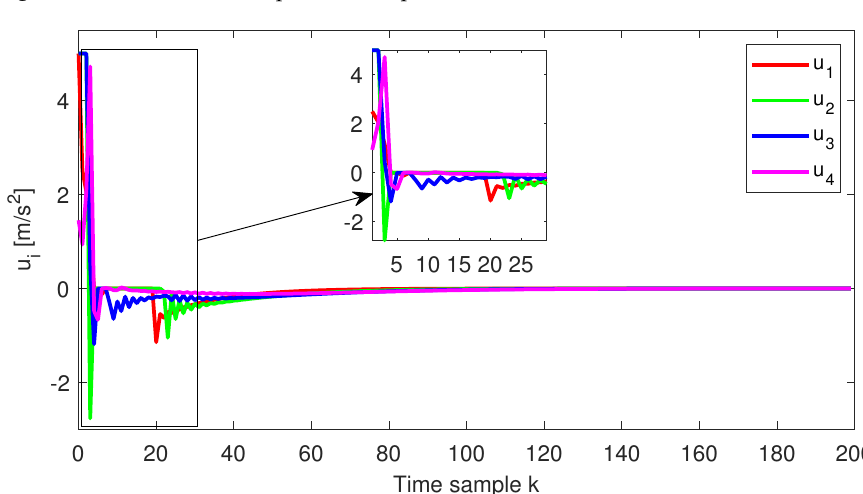
Figure 10. Test 4 —Control input for each platoon vehicle.